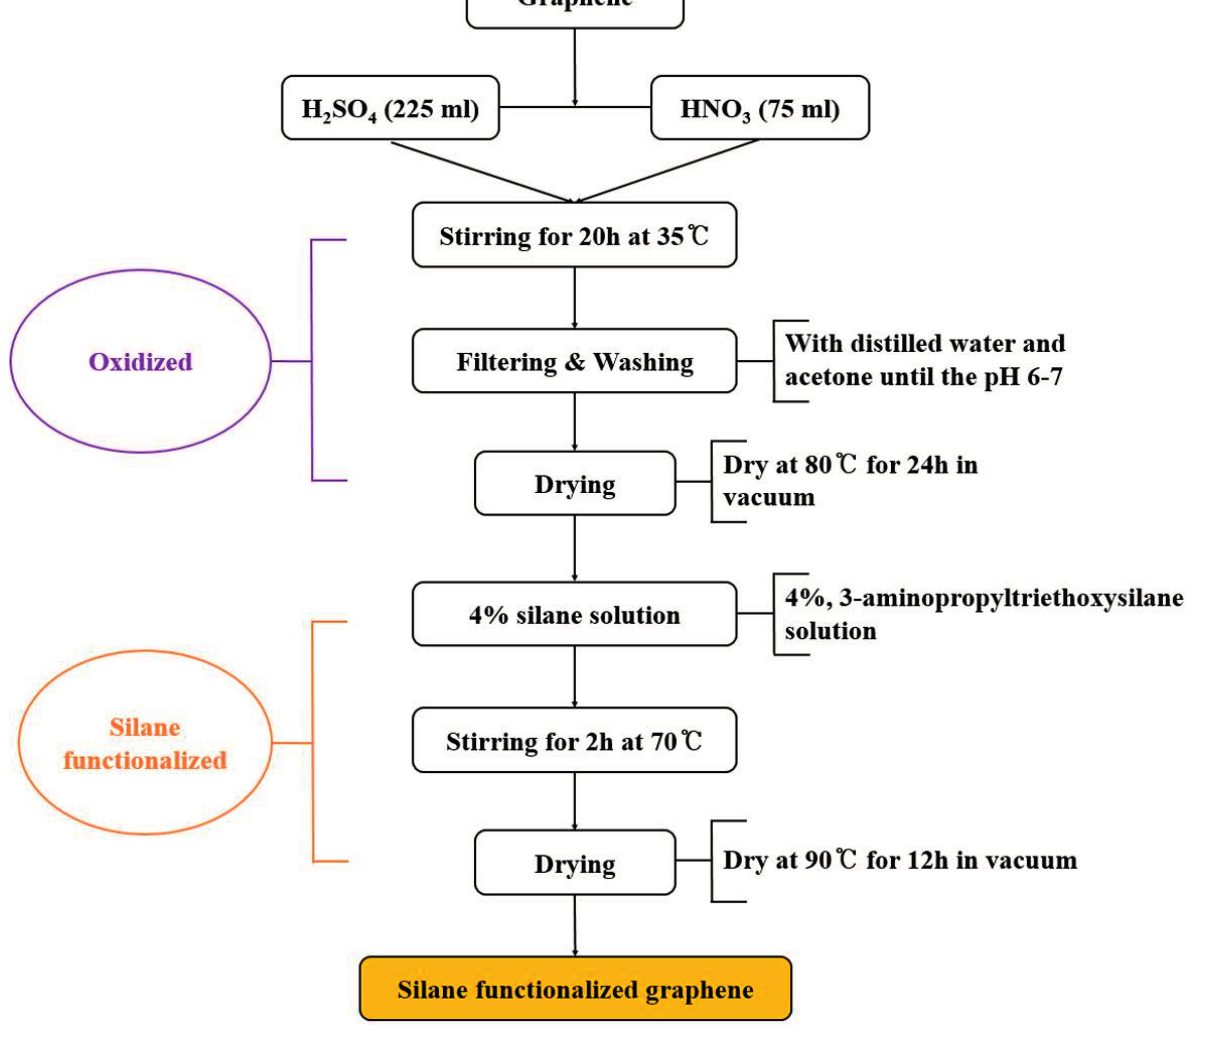
Figure 1. Process flow chart of silane